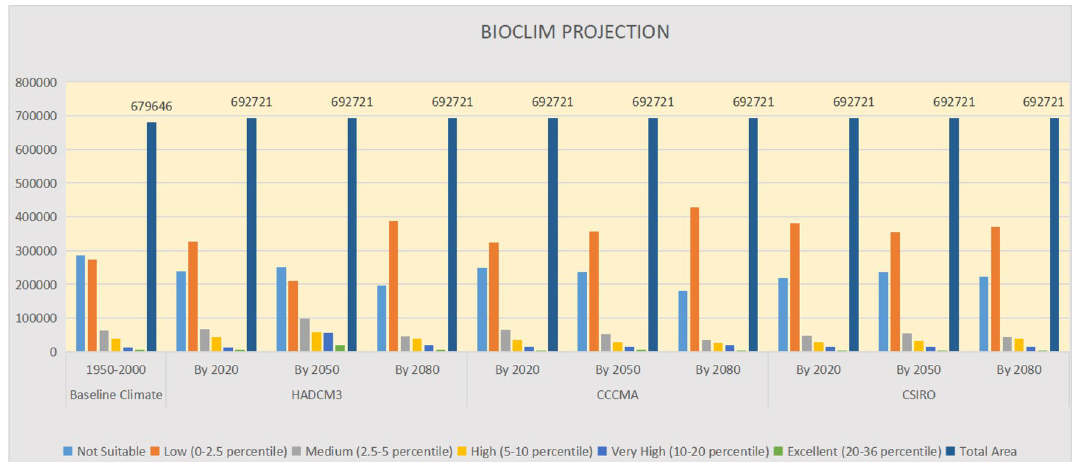
Fig. 7 Comparison of BIOCLIM predicted ecological niches for malaria vectors’ habitats from baseline climate (1950–2000), HADCM3, CCCMA and CSIRO projections